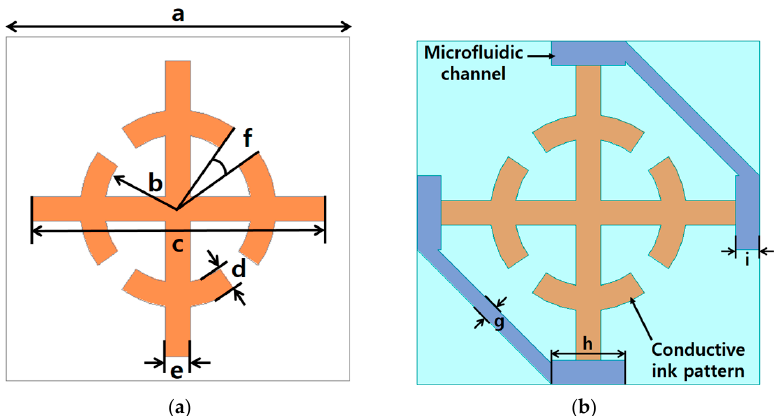
Figure 2. Layout of the proposed metasurface: a = 7 mm, b = 1.5 mm, c = 6 mm, d = 0.5 mm, e = 0.5 mm, f = 20°, g = 0.3 mm, h = 1.5 mm, i = 0.5 mm. ( a ) Without microfluidic channels; ( b ) With microfluidic channels.